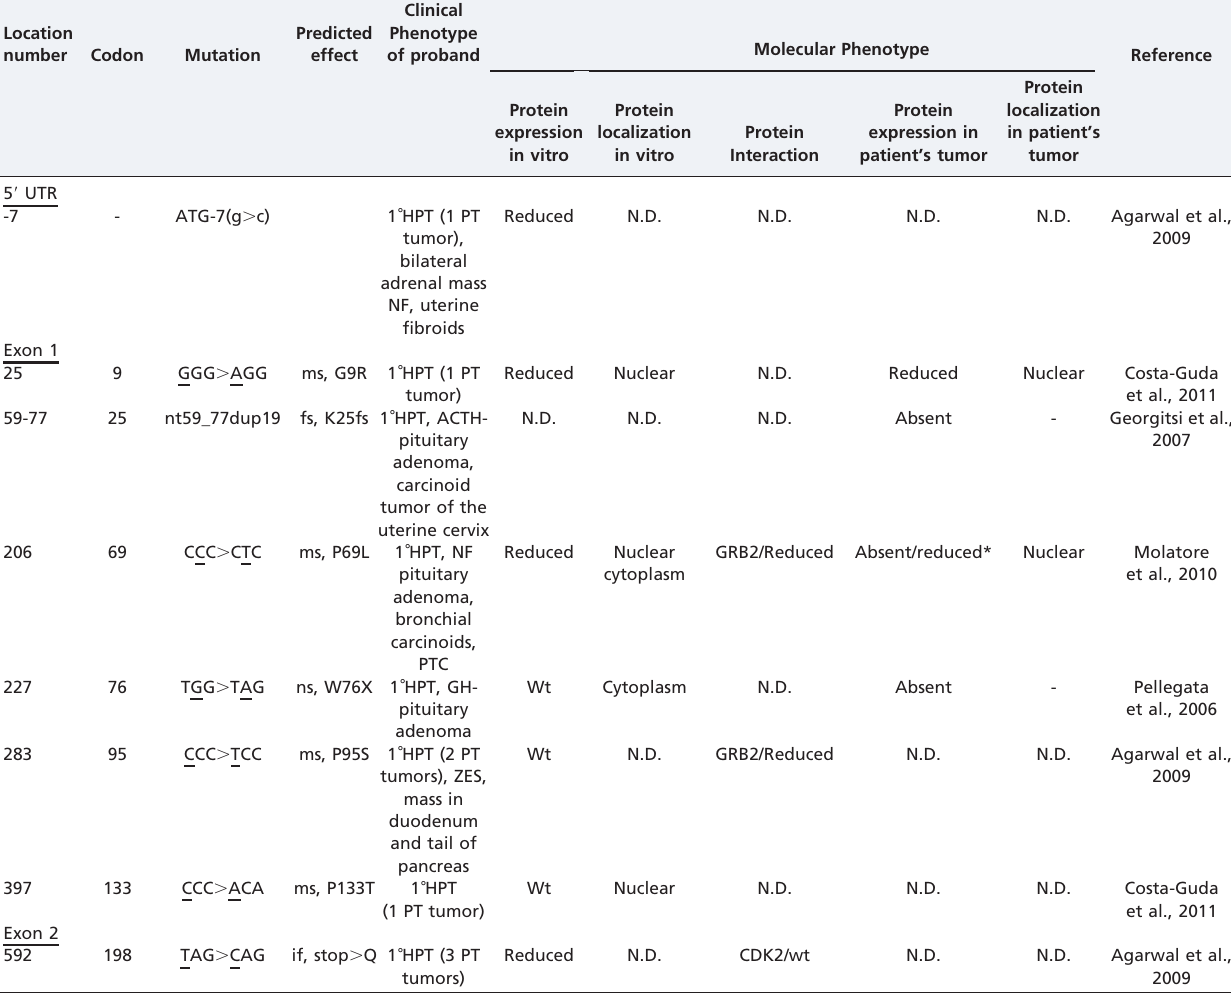
Table 1 - Germline mutations in the CDKN1B gene, phenotype of the mutation carriers and molecular phenotype of the p27 variant proteins. Mutations are numbered referenced to the cDNA sequence AY890407